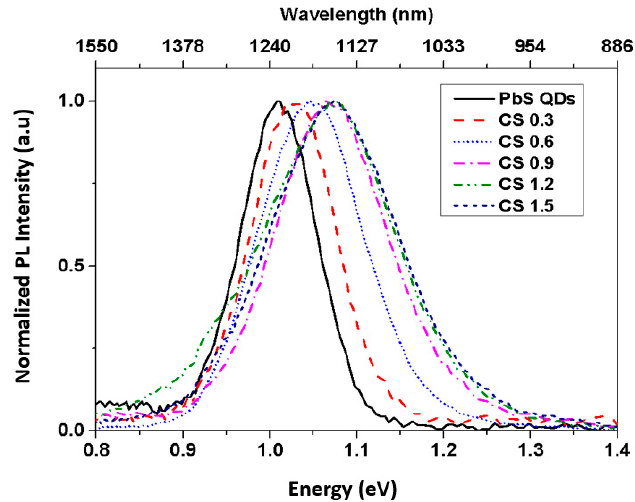
Figure 2. Room temperature photoluminescence (PL) spectra of the colloidal PbS QDs and PbS/MnS core shell QDs. The presence of the MnS shell causes PL peak energy to blueshift.